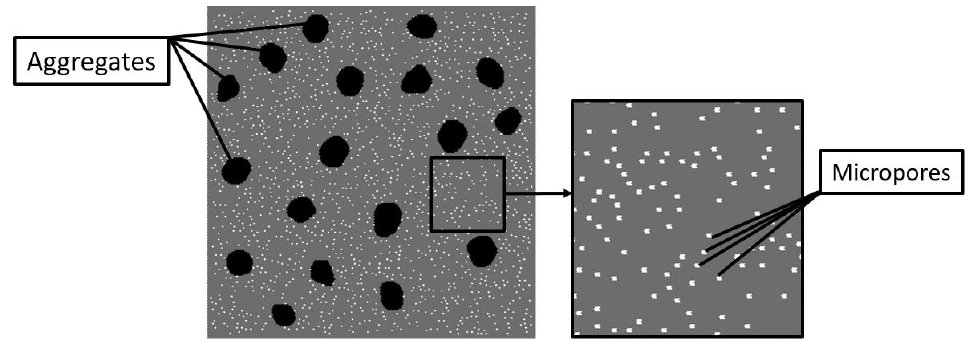
Figure 1. An example of the structure of a mesoscale concrete sample with 10 vol.% of basalt ag- gregates. The volume fraction of micropores is 4%. The volume fraction of micropores is